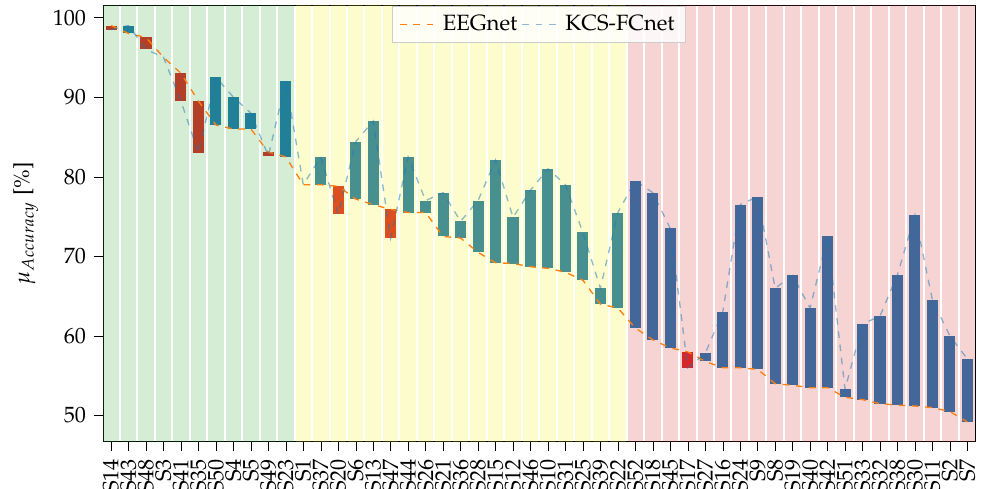
Figure 4. Subject specific results. EEGnet and KCS-FCnet average accuracies are depicted, with subjects being sorted based on their performance using EEGnet. The blue bars represent an im- provement in performance using the KCS-FCnet, while the red bars indicate a decrease in perfor- mance. The background codes the group membership (best—G I, medium—GII, and worst—GIII performance